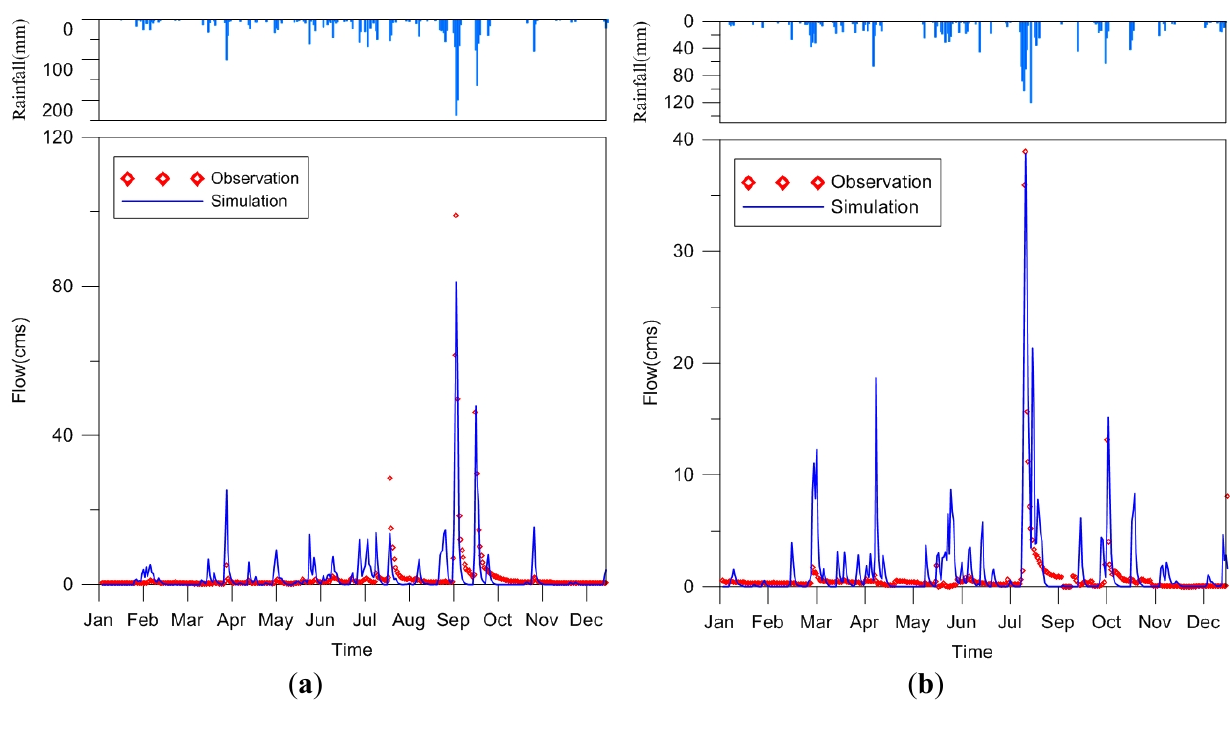
Figure 4. Simulated flow results for: ( a ) calibration performed using 2008 data and ( b ) verification performed using 2009